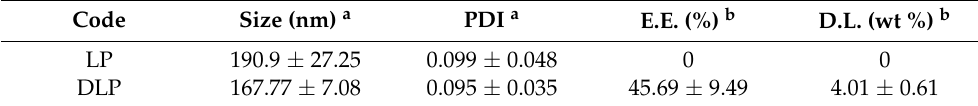
Table 2. The characterization of LP and DLP at 25 ◦ C.